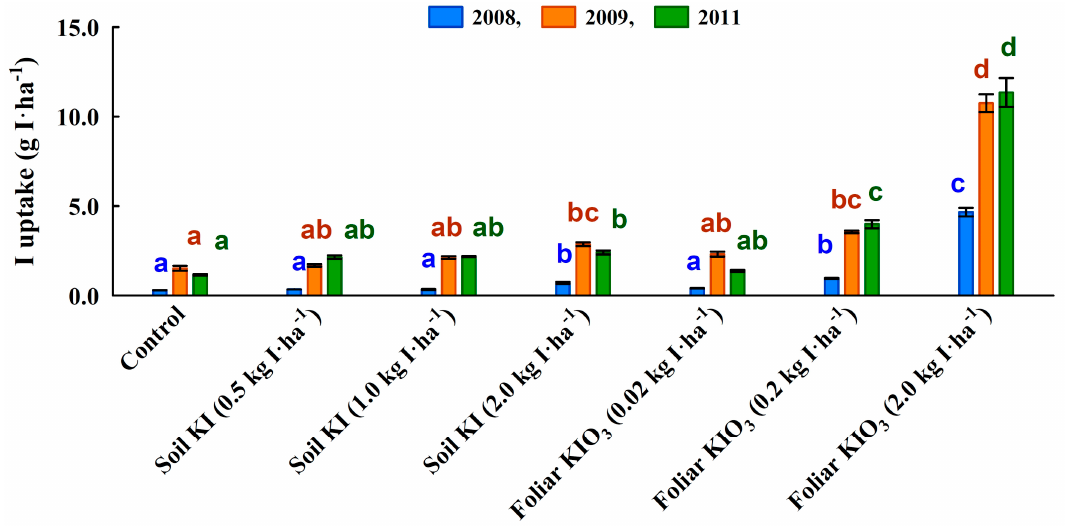
Figure 3. Iodine uptake by potato yield in individual years the study; values followed by the same letters within an individual year are not statistically di ff erent at p < 0.05, ( n =